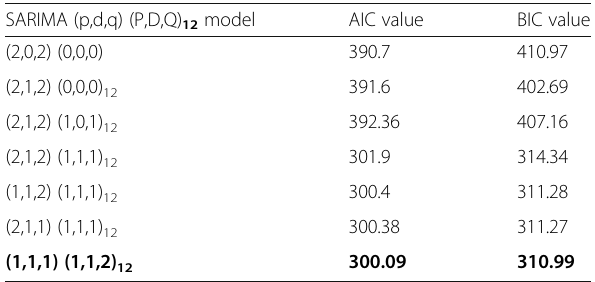
Table 2 Comparison of Akaike information criteria (AIC) value of SARIMA models to find the best fit model SARIMA (p,d,q) (P,D,Q) 12 model